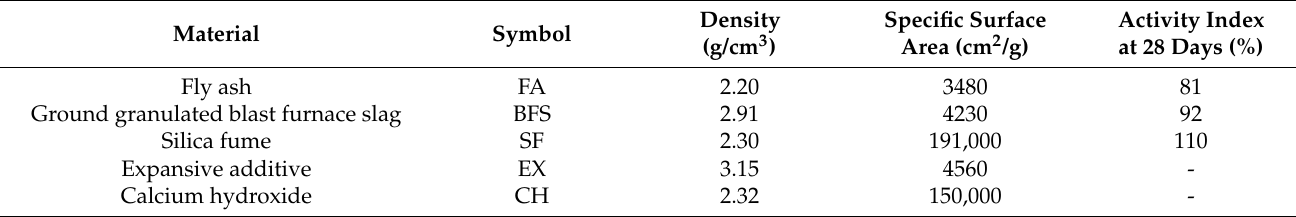
Table 1. Materials for IBPM.